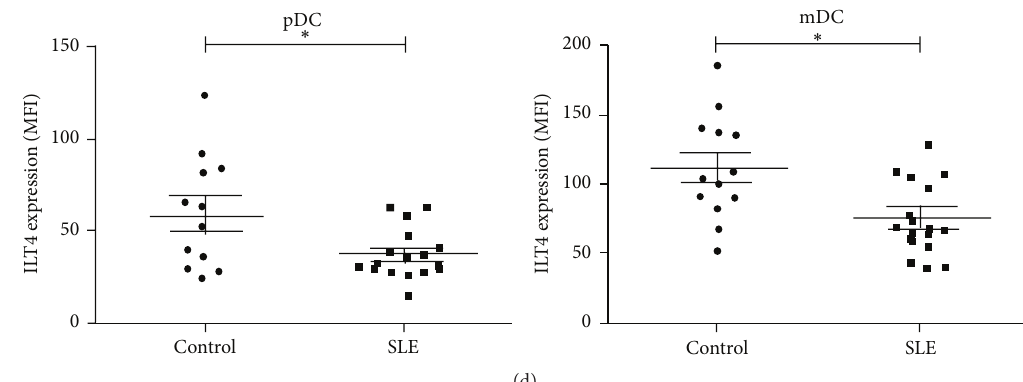
Figure 1: Expression of ILT4 by DC in the peripheral blood from SLE patients and healthy controls. (a) Polychromatic flow cytometry gating tree for lineage-negative (Lin − ), HLA-DR + , CD11c + , and BDCA1 + cells (mDC) and Lin − , HLA-DR + , CD11c − , and BDCA4 + cells (pDC). ILT4 positive cells were evaluated in each subpopulation. Data shown in (b) and (c) were generated based on this gating tree. Cut-offs for background fluorescence were based on isotype-matched Ig negative controls and FMO (Fluorescence Minus One) strategy. (b) PBMCs from SLE patients and healthy subjects included in the study were immunostained for the detection of ILT4 expression on pDC and mDC by flow cytometry, as stated in Section 2. Percentages of ILT4 + mDC or ILT4 + pDC were calculated for Lin − HLA − DR + CD11c + BDCA1 + or Lin − HLA − DR + CD11c − BDCA4 + cells, respectively. Representative histograms from cells of one control and one SLE patient (upper and lower panel, resp.) are shown. Numbers indicate the percentage of BDCA4 + cells from Lin − HLA-DR + CD11c − gate or BDCA1 + cells from Lin − HLA- DR + CD11c + gate (first and third panels) and ILT4 + leukocytes from Lin − HLA-DR + CD11c − BDCA4 + or Lin − HLA-DR + CD11c + BDCA1 + gate (second and fourth panels). (c) Percentages of ILT4 positive pDC (left panel) and mDC (right panel) from SLE patients and healthy controls. ∗ 𝑝 < 0.05 . (d) MFI of ILT4 expression on pDC (left panel) and mDC (right